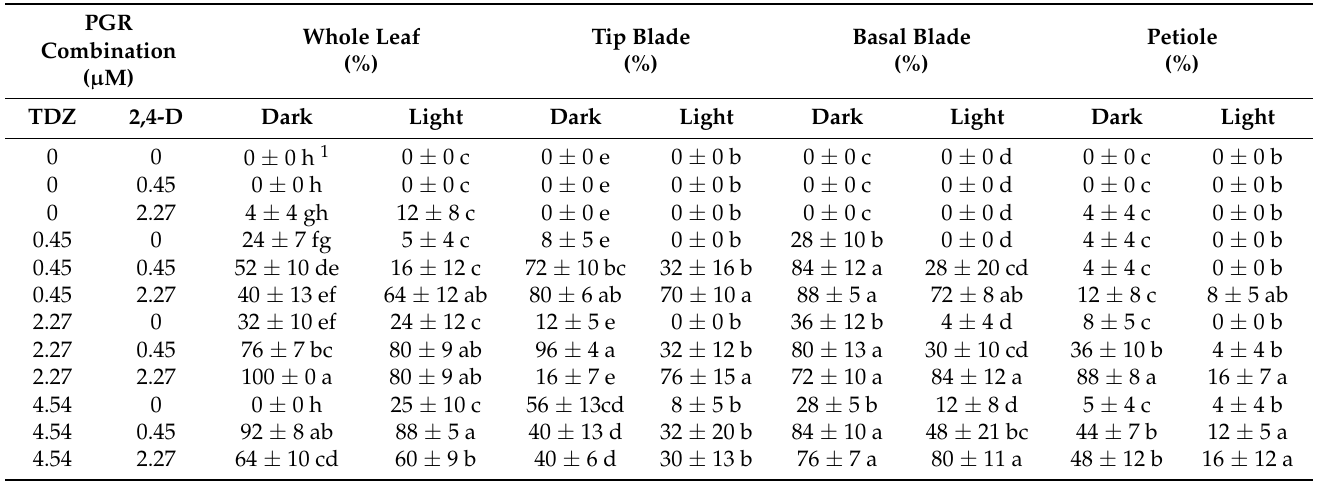
Note: (1) Means ± standard error of 5 replicates with the same letters are not significantly different at p < 0.05; (2) the cultures were in the dark or under a 16:8 h photoperiod at 3500